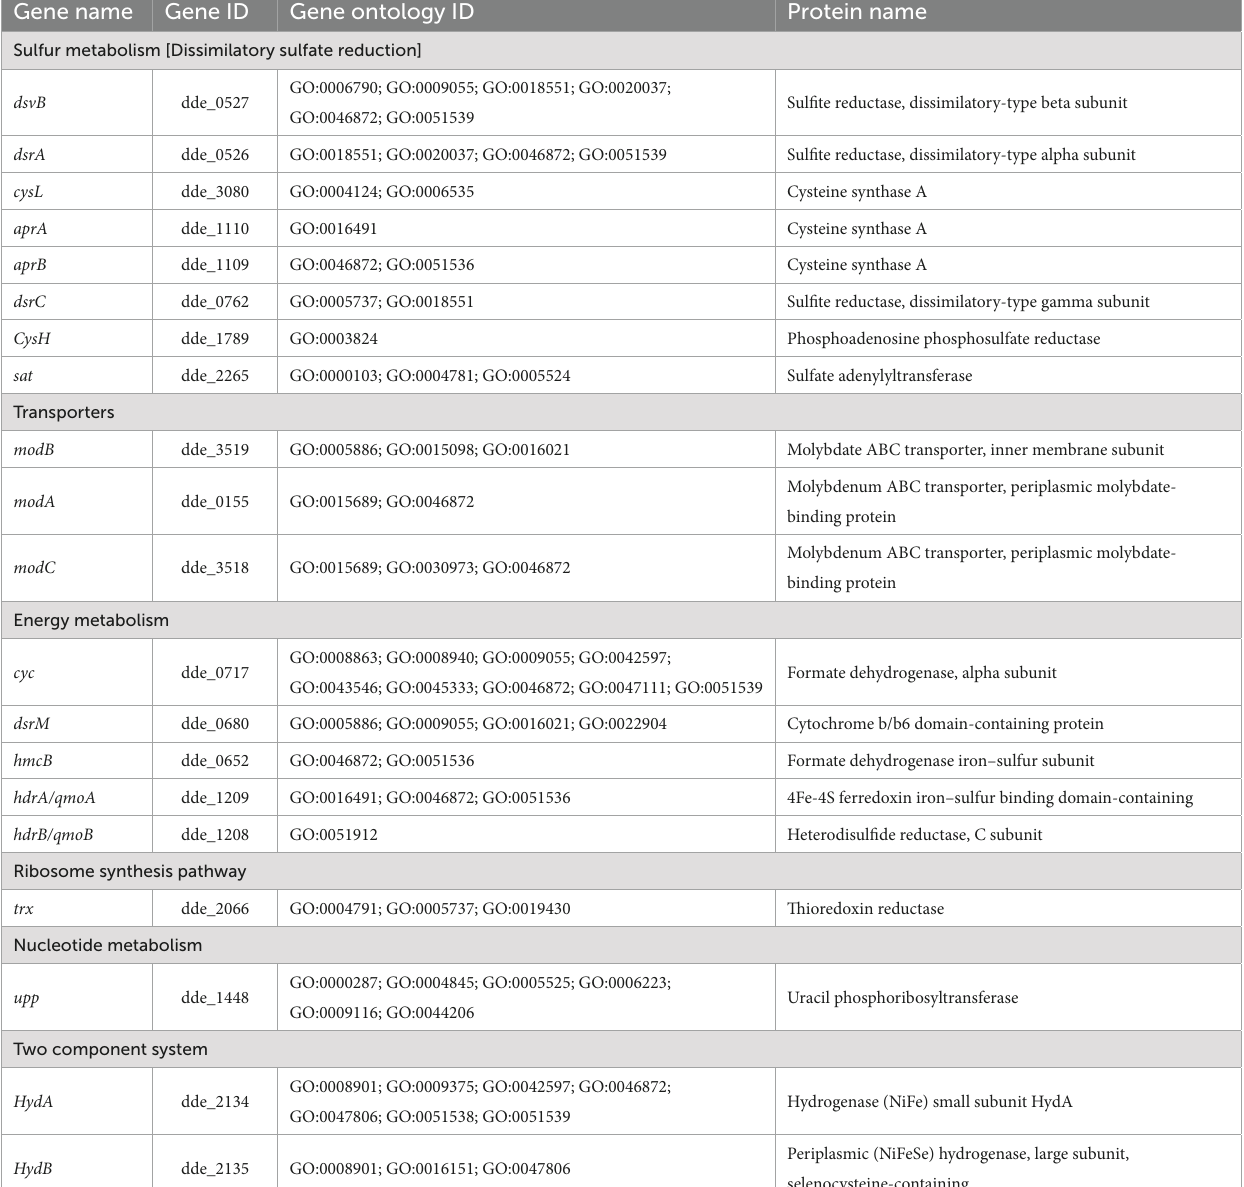
TABLE 1 Annotated gene list subcategorized under different